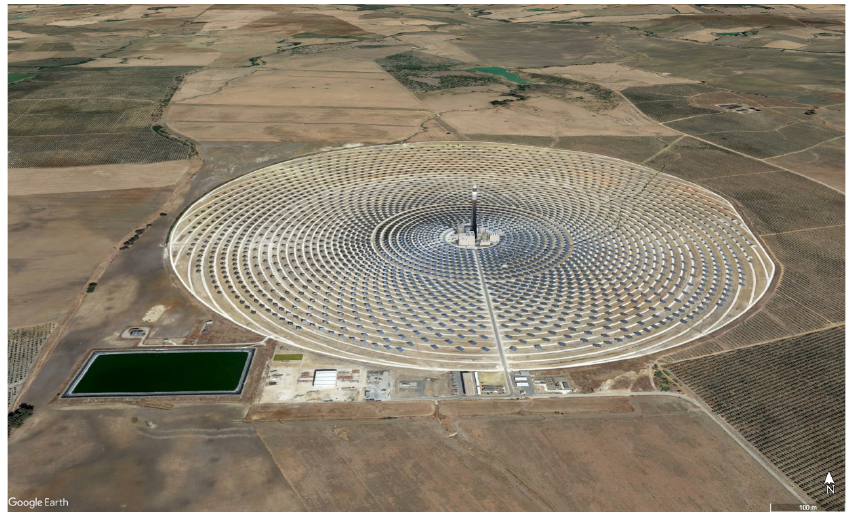
Figure 1. Gemasolar thermosolar power plant located in the province of Sevilla, Spain (37.560613 ◦ N, 5.331508 ◦ W). All rights reserved ( © Google Earth